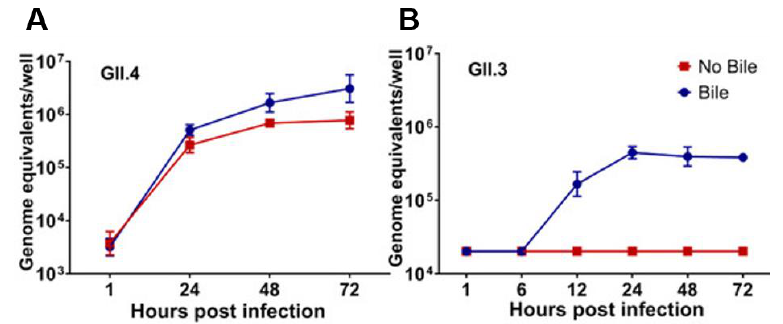
Figure 4. GII.3 but not GII.4 HuNoV infection requires bile. Virus growth curves show enhanced RNA replication of GII.4 in the presence of human bile ( A ). Replication of GII.3 required the addition of human bile to cultures ( B ). Error bars denote standard deviation (from [51]. Reprinted with permission from AAAS).